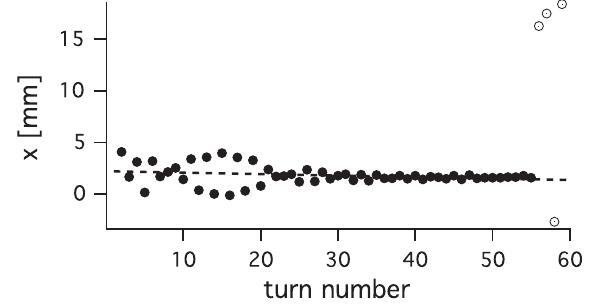
FIG. 6. Example turn-by-turn horizontal coordinate measured by a single BPM. The closed orbit is calculated by doing a linear fit to the coordinates (dashed line). Coordinates more than 3 σ from the mean are ignored by the fit (open circles).